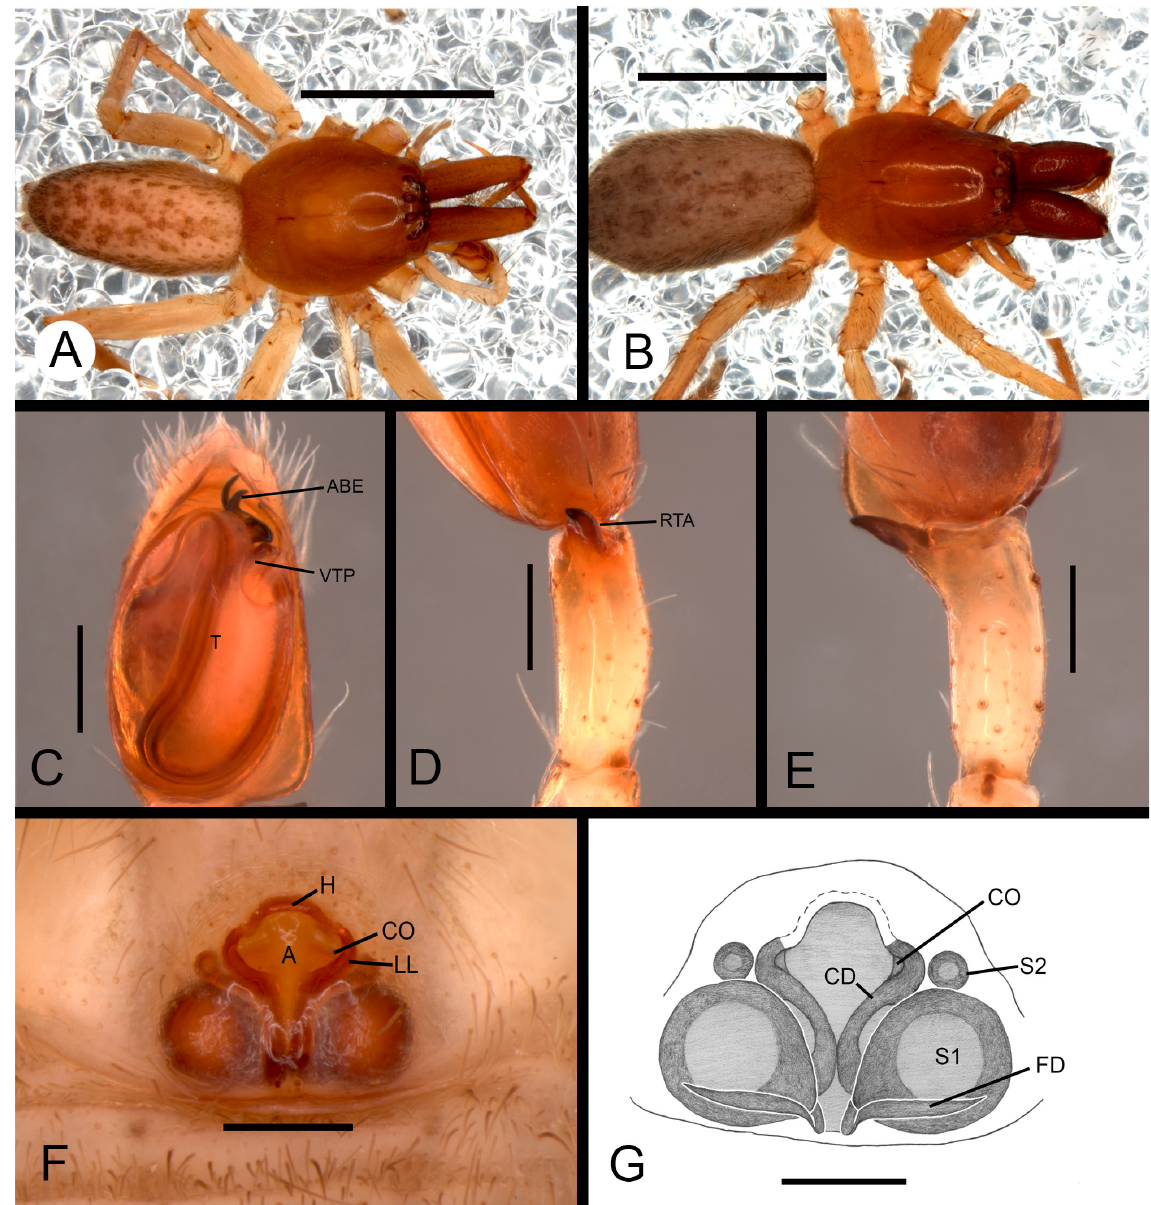
Fig. 17. Tafana nevada sp. nov. (A, C–E = holotype, ♂, AMNH; B, F–G= paratype, ♀, AMNH). A . Habitus, dorsal view. B . Habitus, dorsal view. C . Left palp, ventral view. D . Left palp, retrolateral view. E . Left palp, dorsal view). F . Epigynum, ventral view. G . Vulva, dorsal view. Abbreviations: A = atrium; ABE = apophysis of base of embolus; CD = copulatory ducts; CO = copulatory opening; FD = fertilization ducts; H = hood; LL = lateral lobes; RTA = retrolateral tibial apophysis; S1 = primary spermathecae; S2 = secondary spermathecae; T = tegulum, VTP = ventral tegular process. Scale bars: A–B = 3.5 mm; C–G = 0.25